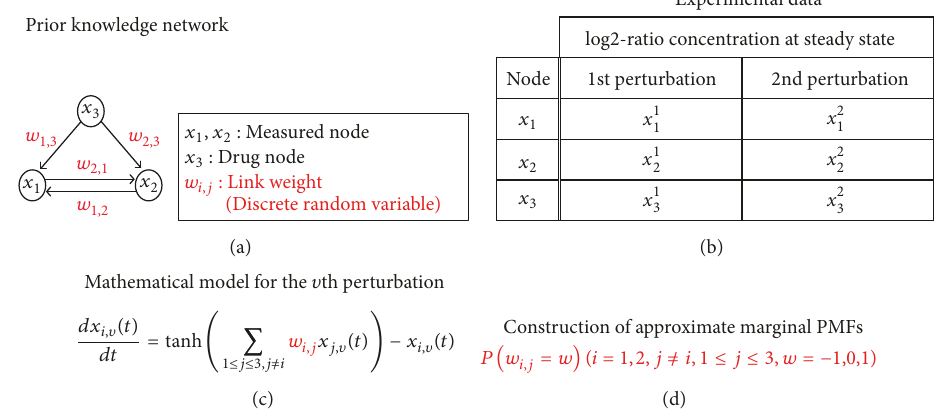
Figure 1: Given information and our goal. (a) A prior knowledge network of two measured nodes 𝑥 1 and 𝑥 2 , and one drug node 𝑥 3 . The symbol 𝑤 𝑖,𝑗 denotes the link weight from 𝑥 𝑖 to 𝑥 𝑗 , which is a discrete random variable. (b) Experimental data. The 1 𝑠𝑡 and 2 𝑛𝑑 perturbations mean the 1 𝑠𝑡 and 2 𝑛𝑑 experiments. Symbol 𝑥 𝜐 𝑖 (𝑖 = 1, 2, 3, 𝜐 = 1,2) denotes the log 2 -ratio concentration of 𝑥 𝑖 at steady state before and after the 𝜐 𝑡ℎ perturbation. (c) Differential equation model for the 𝜐 𝑡ℎ perturbation. Symbol 𝑥 𝑖,𝜐 (𝑡) denotes the relative change of 𝑥 𝑖 at time 𝑡 in the 𝜐 𝑡ℎ perturbation. (d) Construction of approximate marginal PMFs from a joint PMF. Set {𝑤 | 𝑤 = −1, 0,1} denotes the domain of each marginal